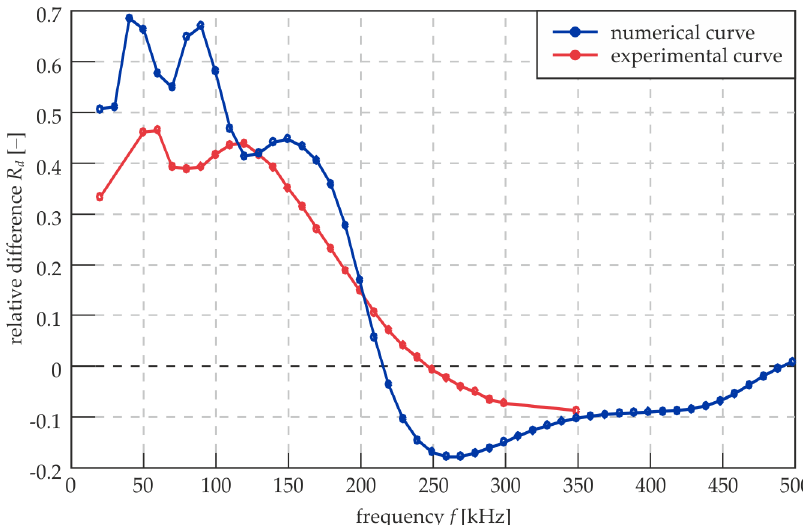
Figure 10. Relative difference between mean RMS values for damaged and intact areas of overlap for experimental (frequency range from 20 to 350 kHz) and numerical results (frequency range from 20 to 500 kHz).